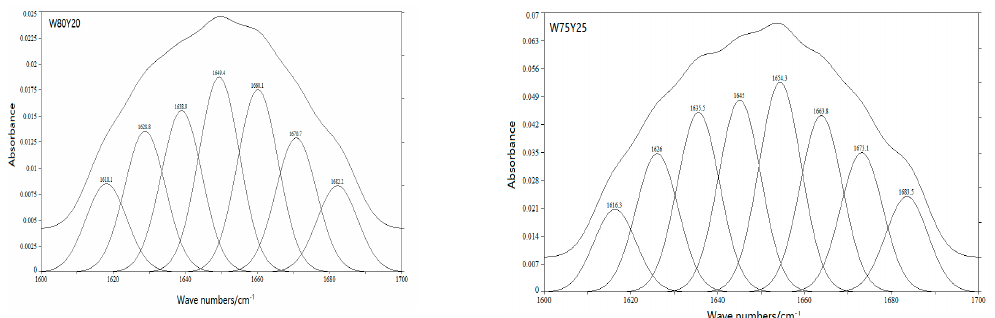
Figure 3. Second-derivative spectra in amide I band of gluten proteins enriched with different levels of yam flour. Table 3. Secondary structure of gluten protein in wheat dough enriched with different amounts of yam flour.